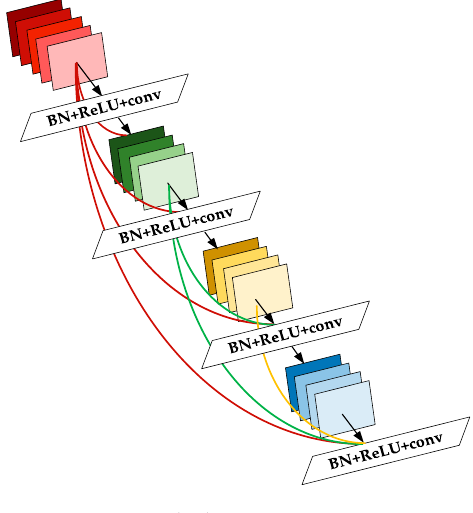
Figure 3. Dense Block. Figure 3. Dense